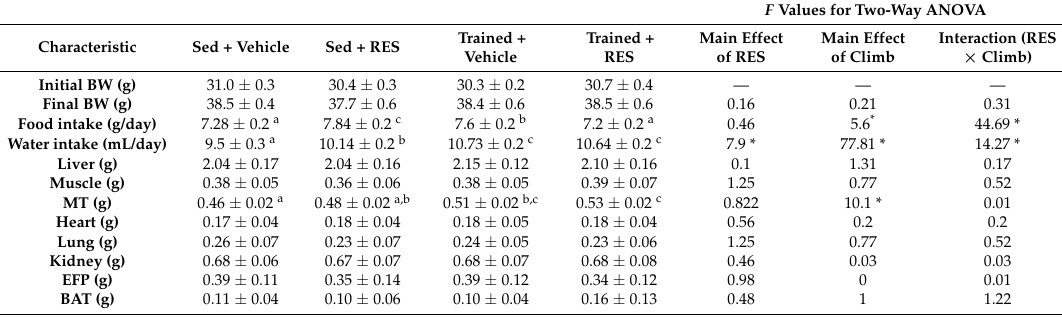
Table 3. General characteristics of the experimental